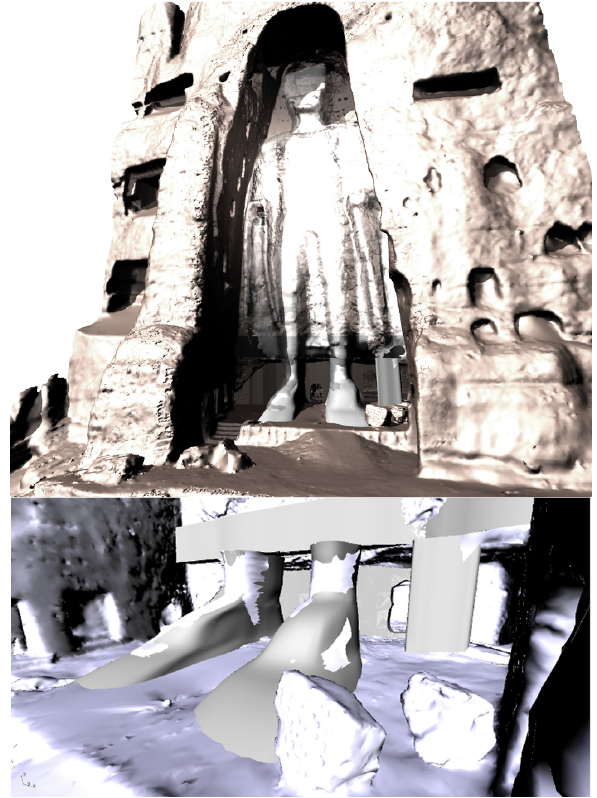
Figure 3. Simulation of the situation around the virtually reconstructed feet of the 38m Buddha statue with simplified model of the niche modeled in Autodesk 3ds